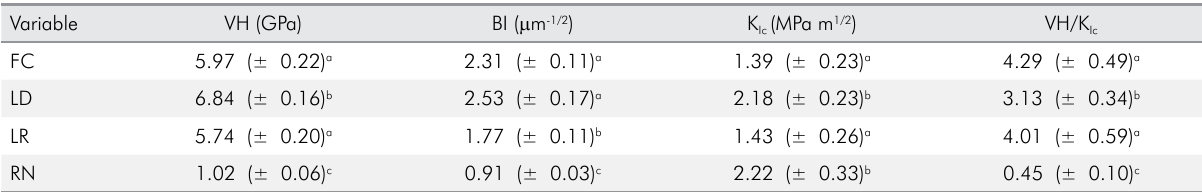
Table 2. Means and standard deviation (± SD), for first column Vickers hardness (VH - GPa); second column Brittleness index (BI - μ m -1/2 ); third column fracture toughness K K , across the materials type. Ic